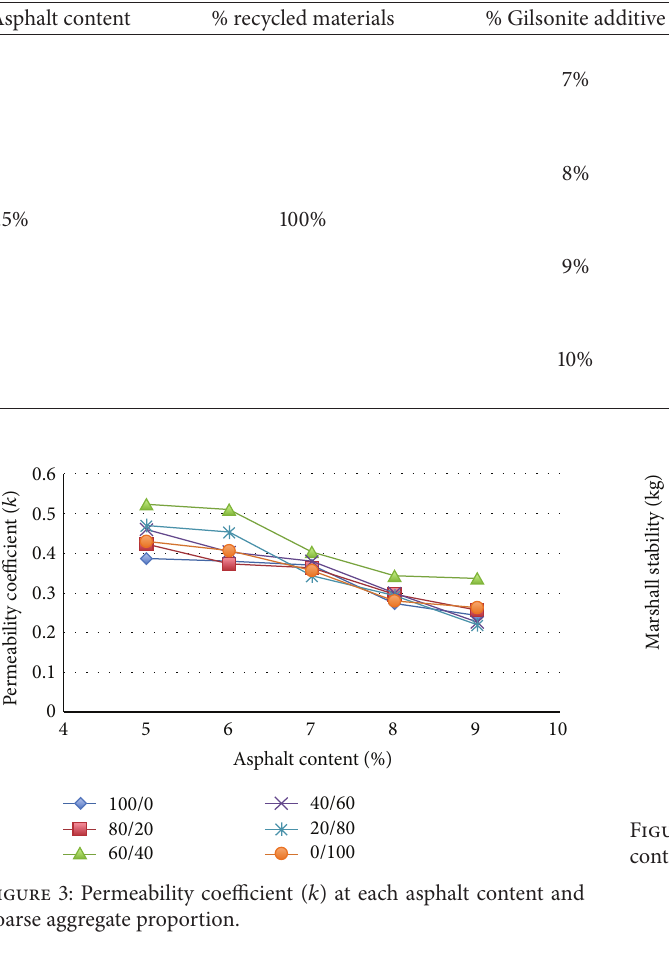
Table 10: Marshall characteristics at different percentage of Gilsonite additive.